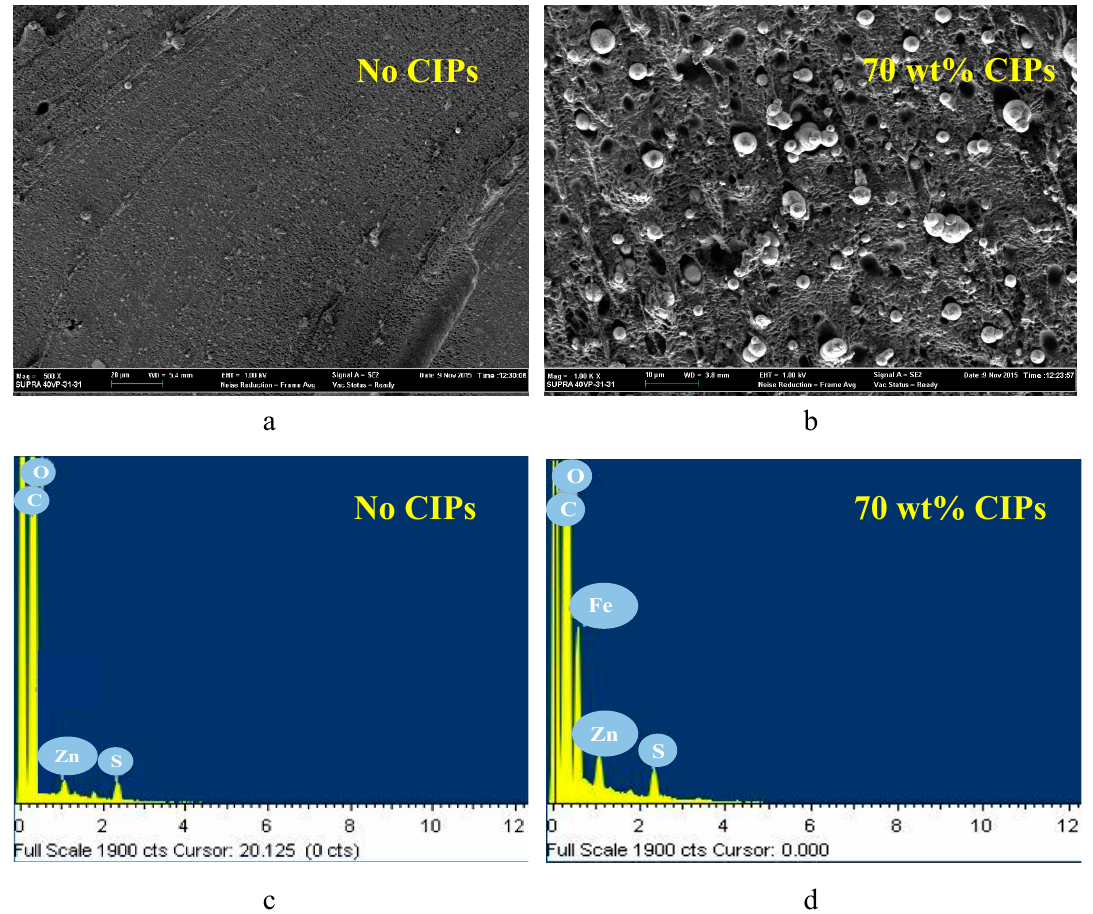
Figure 2. Micrographs and EDX graphs of samples with ( a ) and ( c ) no CIPs, and ( b ) and ( d ) 70 wt % of CIPs at 1000x magnification.